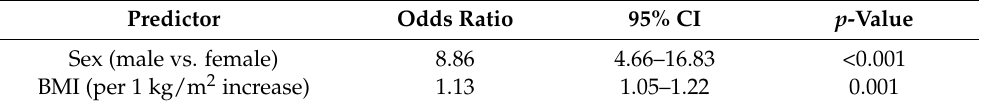
0.323 Smoking 1.592 0.82–3.1 0.171 Family history of CAD 0.677 0.393–1.16 0.159 History of CAD 3.35 1.77–6.35 <0.001 2.91